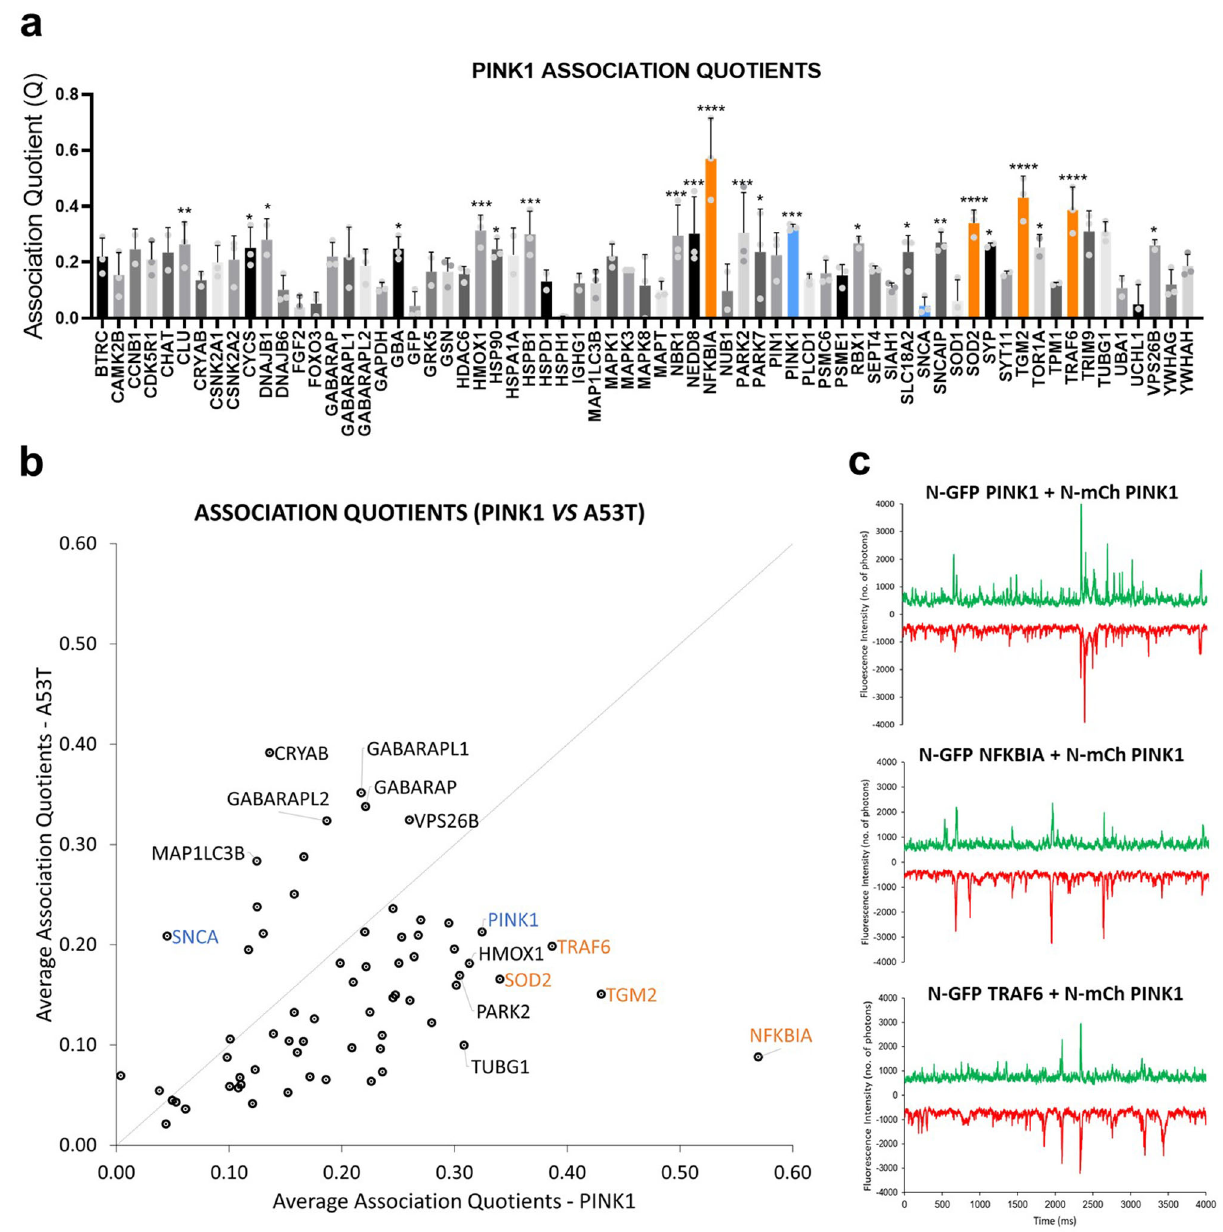
Fig. 6 The interactome of PINK1 highlights selective recognizers of A53T α -synuclein. a Bar plot of Q values for all triplicated co-expression levels between N-mCherry PINK1 and N-GFP LB proteins (300 s traces). Error bars represent mean ± SEM. Dunnett ’ s multiple comparisons test against traces of co-expression with monomeric GFP. **** p ≤ 0.0001, *** p ≤ 0.001, ** p ≤ 0.01, * p ≤ 0.05, n = 3. b Plots of average Association Quotients for co-expression with A53T ( Y axis) and PINK1 ( X axis). Controls for each co-expression are represented in blue (i.e. SNCA-A53T and PINK1-PINK1). Diagonal line represents interactors that were not selective for either A53T or PINK1. Highest Q values for interactors of PINK1 represented in orange. c Four-second representation of traces for main interactors of PINK1. For all traces, GFP signal is represented in positive axis, mCherry signal in negative itself have high Q values for A53T but low Q values for PINK1. The scatter plot also reveals speci fi c interactors of PINK1, such as PARK2 22 , TRAF6 23 and TGM2 24 (Fig. 6c), all of which are known interactors of PINK1, suggesting that our co-aggregation experi- ments can indeed reveal selective binding.